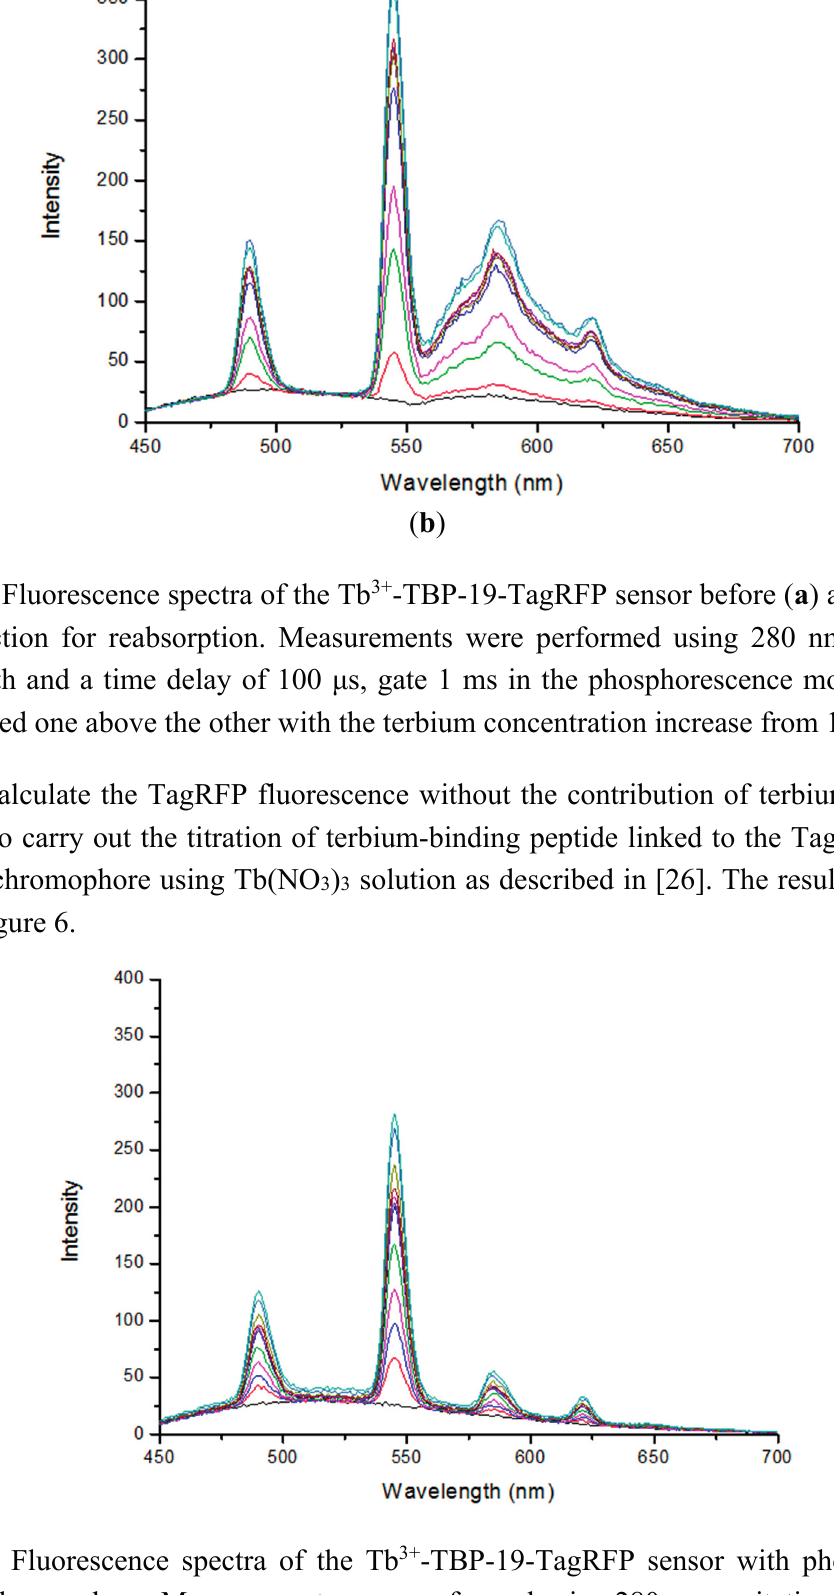
Figure 6. Fluorescence spectra of the Tb 3+ -TBP-19-TagRFP sensor with photobleached TagRFP chromophore. Measurements were performed using 280 nm excitation wavelength and a time delay of 100 μ s, gate 1 ms in the phosphorescence mode. Spectra are arranged one above the other with the terbium concentration increase from 1 to 50